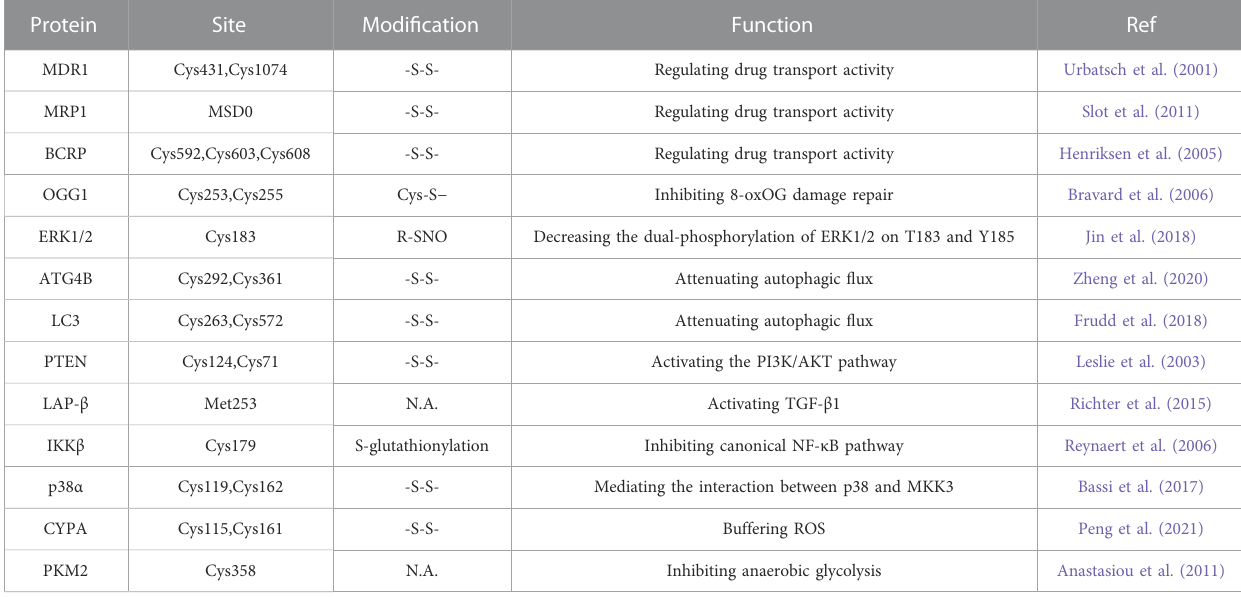
TABLE 1 Summary of redox sensors correlated with drug resistance.